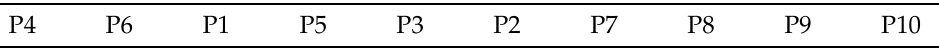
time, BT: Burst time, CT: completion time, TAT: Turn around time, and WT: waiting time. Table 5. Torque job execution order on a single